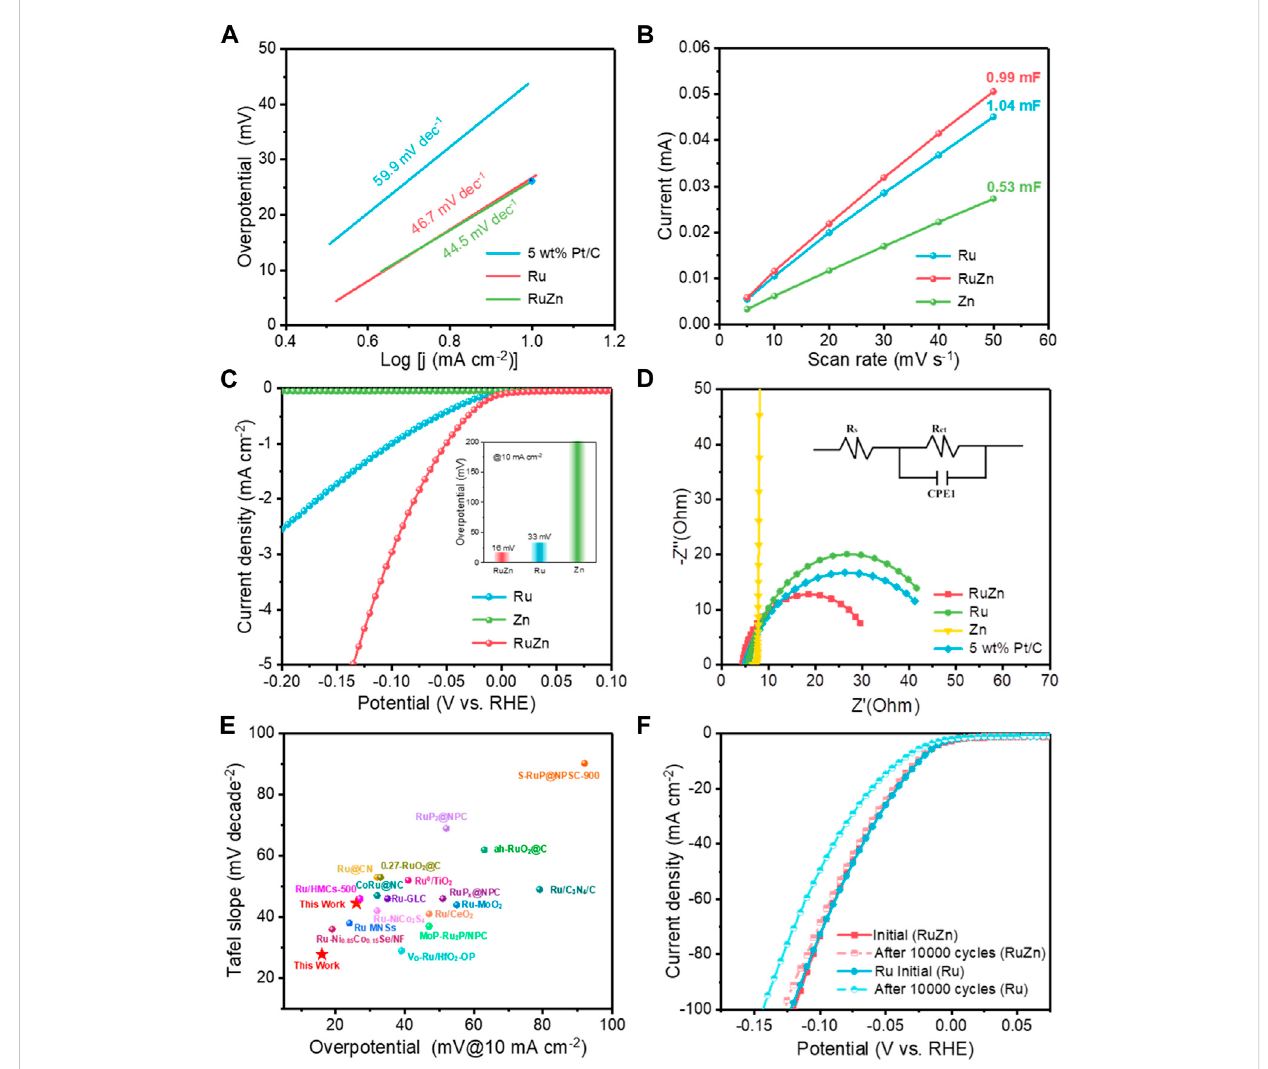
FIGURE 3 The electrocatalytic HER performances of the 4 wt% Ru-Zn/MWCNTs catalysts and the counterparts in 1 M KOH. (A) Tafel plots; (B) Capacitive currents against the scan rate and the corresponding C dl valuesestimated through linear fi tting of the plots; (C) The speci fi c activity normalized by ECSA; (D) EIS Nyquist plots at overpotential of 50 mV and the corresponding equivalent circuit diagram; (E) Performances comparison of the Tafel slope and overpotential at a current intensity of 10 mA cm − 2 with the Ru-based catalysts reported previously; (F) Duration test after 10,000 cycles of CV sweeps. (Ru, Zn and RuZn refer to 4 wt% Ru/MWCNTs, 4 wt% Zn/MWCNTs, and 4 wt% Ru-Zn/MWCNTs,